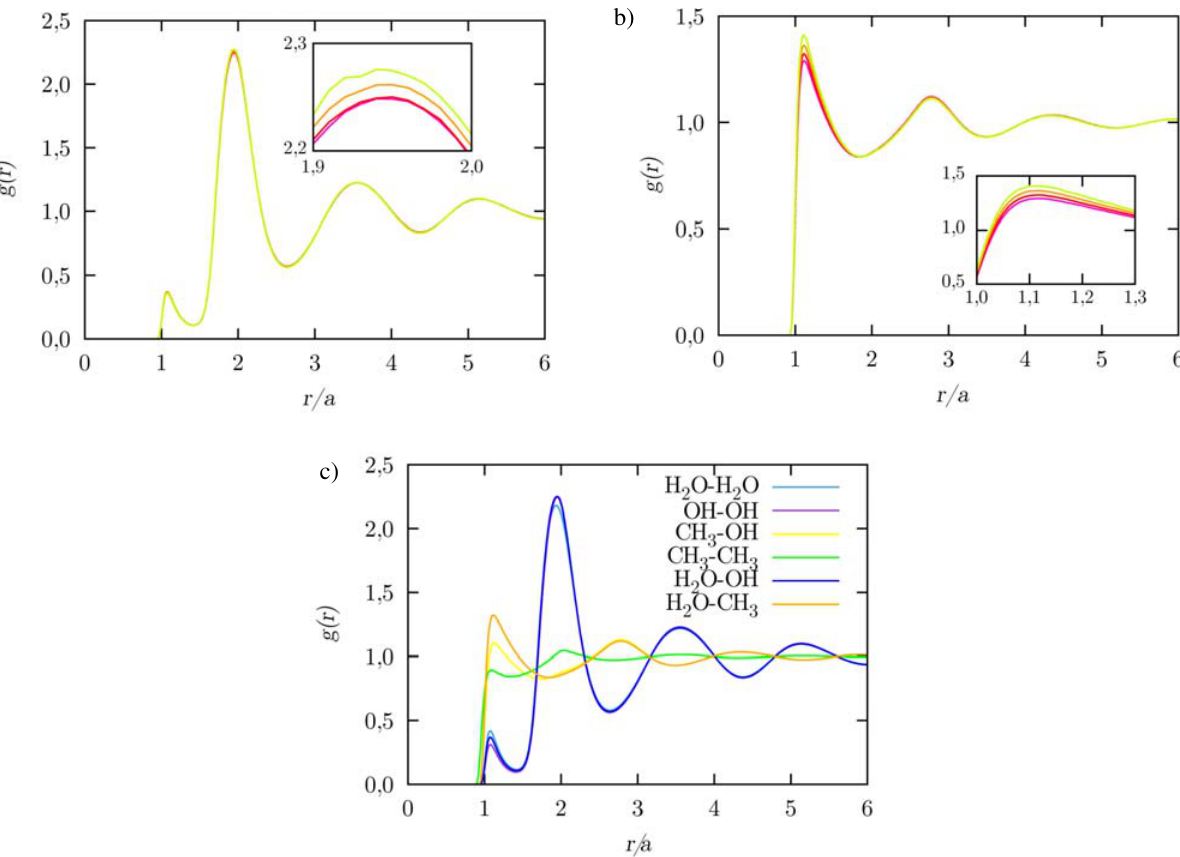
Figure 4: Pair distribution functions in water/methanol mixtures at T* = 0.6 for different mass fractions of methanol – 20% (pink), 40% (red), 60 (yellow) %, 80% (green) – as predicted by our model. Hydroxyl-water (panel a) and methyl-water (panel b) functions are weakly dependent on the methanol fraction. Panel c shows comparison with intraspecies methanol and water distribution